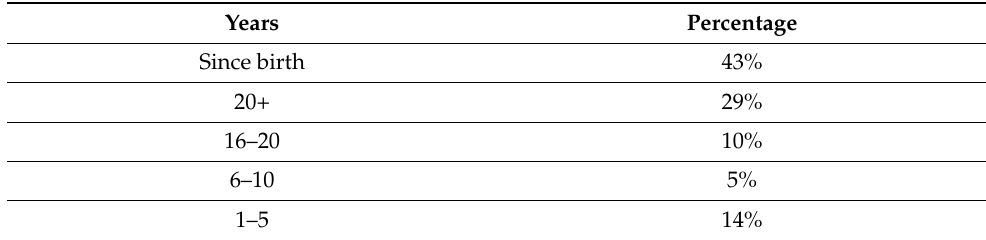
Table 2. Length of residency in